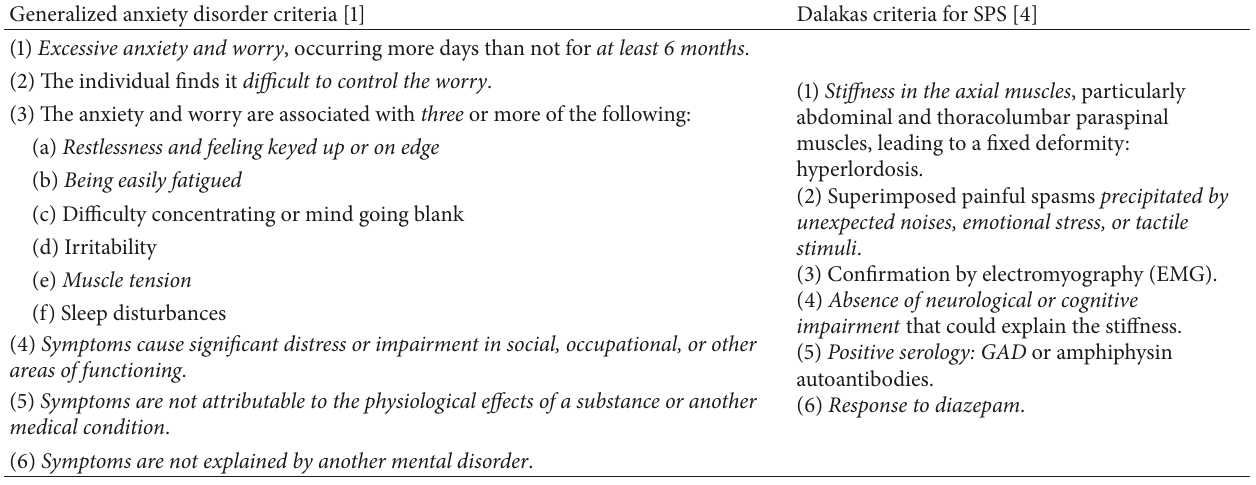
Table 1: Diagnostic criteria for generalized anxiety disorder compared to Dalakas criteria for